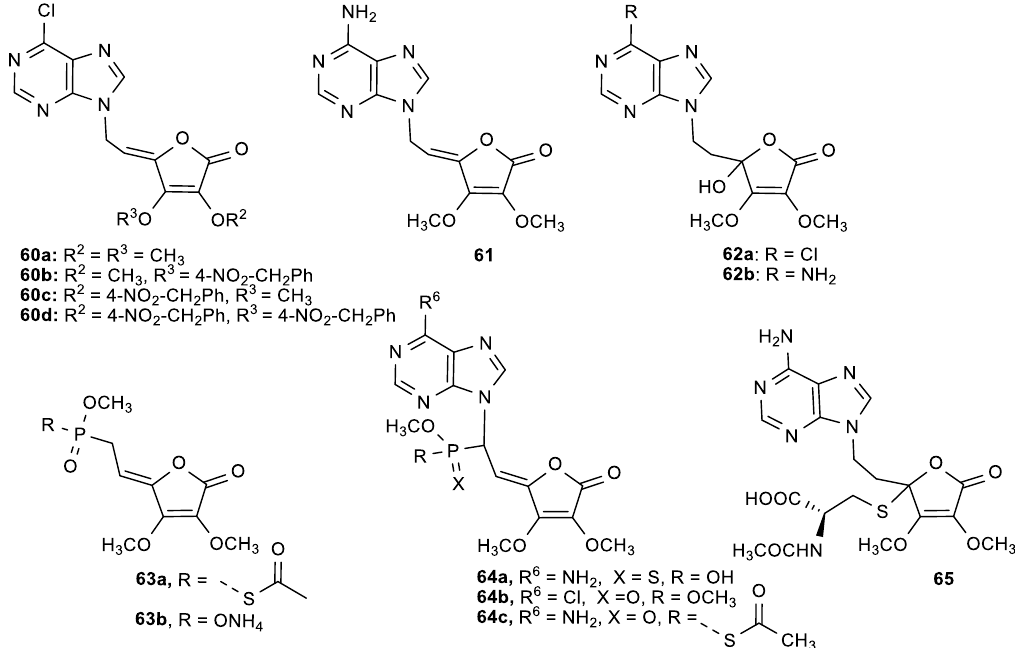
Figure 24. Conjugates of purines and butenolides ( 60 − 62 ), phosphonobutenolides ( 63 , 64 ) and the N -acetyl- L -cysteine adduct ( 65 ). Table 24. The anticancer and anti-varicella-zoster virus (VZV) activity of purine and butenolide conjugates.